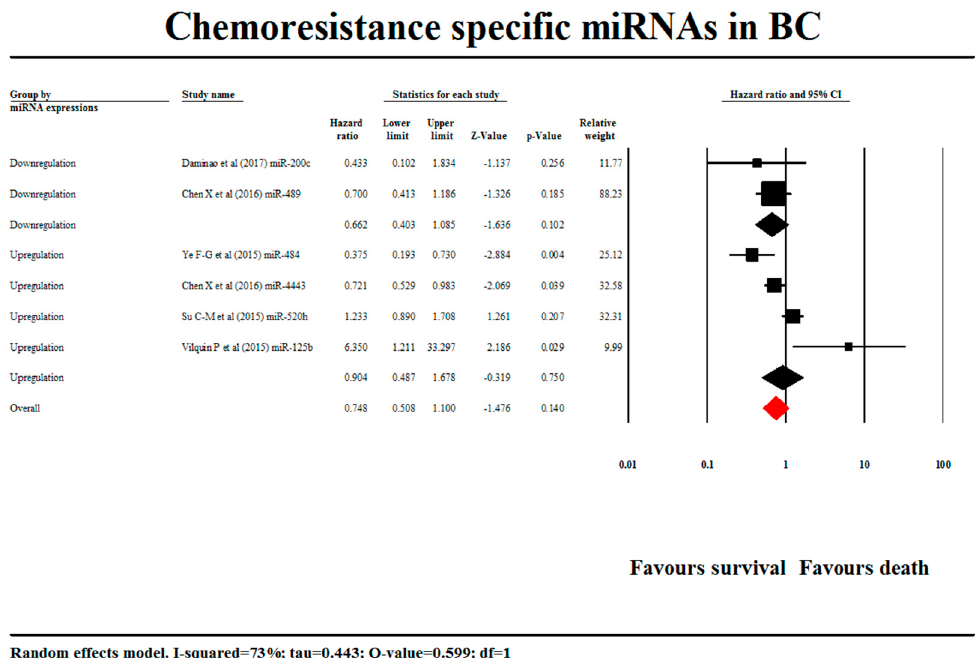
Figure 2. Forest plot of the studies included in our meta-analysis. BC: breast cancer.